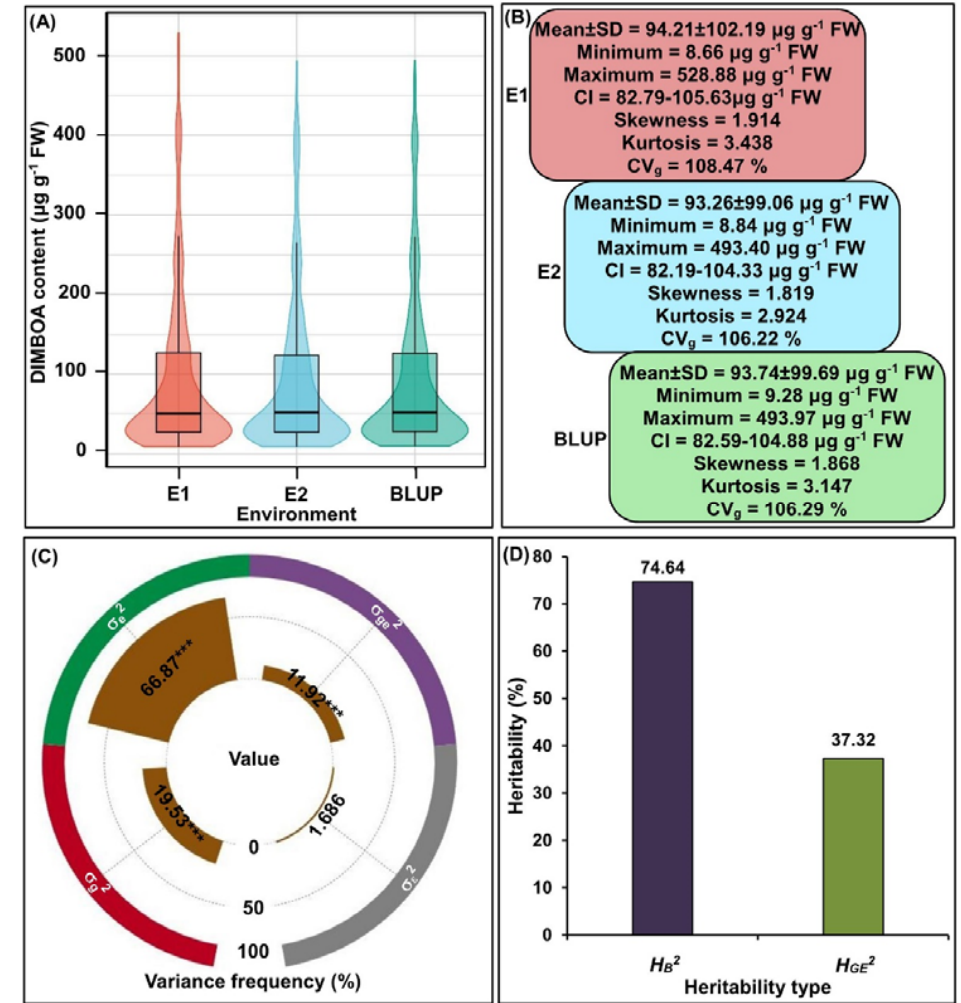
Figure 1. Statistical analysis of DIMBOA content at V6 stage in Zhangye (E1) and Longxi (E2) ecological environments among 310 maize inbred lines seedlings in Gansu Province, China in 2020 and their best linear unbiased prediction (BLUP) values. ( A ) Violin plot shows the DIMBOA content in E1 and E2 environments, and their BLUP values among all inbred lines. ( B ) The statistics including mean ± standard deviation (SD), minimum, maximum, confidence interval (CI), skewness, kurtosis, and genetic variation coefficient (CVg) of DIMBOA content and their BLUP values among all inbred lines in E1 and E2 environments. ( C ) Frequency of the genotypic variance ( σ g2 ), environmental variance ( σ e2 ), genotype × environment interaction variance ( σ ge2 ), and error variance ( σ ε 2 ) for DIMBOA content; *** indicated a significant difference with p < 0.01 (ANOVA). ( D ) The broad-sense heritability ( H 2 ) and genotype × environment interaction heritability ( H 2 ) of DIMBOA content. B GE